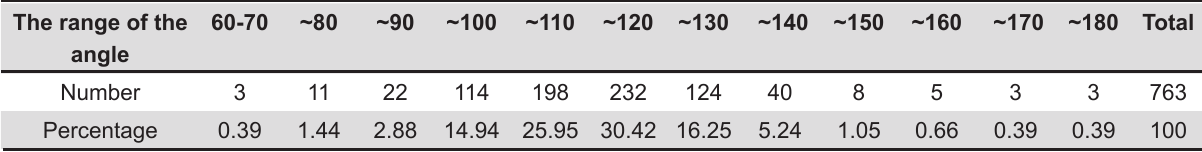
Table 4- ∠ PDM variability (the angle formed by the palatal, distobuccal and mesiobuccal root canal orifices) The range of the